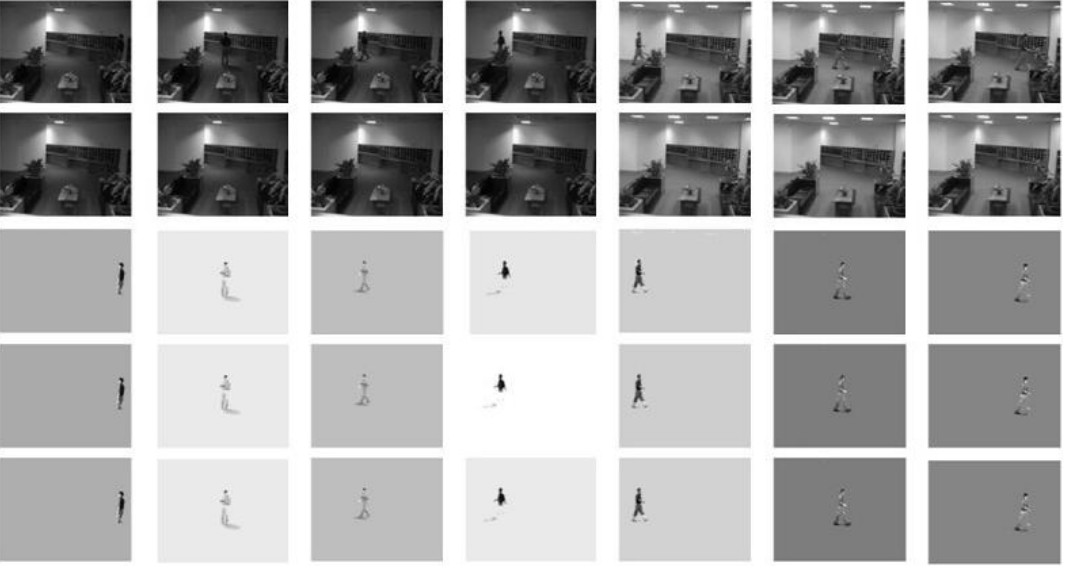
Figure 7. Foreground recovery from video compressive sensing on ―lobby‖ dataset. The 1 st row is original video frames; the 2 nd row shows the estimated background images by IALM [21] that are used to train our fixed low-rank subspace; the 3 rd row shows the   ; the 4 th row shows the recovered foreground with CS measurement ratio 20% cs   ; and the last row shows the recovered foreground recovered foreground with 5% cs   . The sparsity is set as with 1% cs